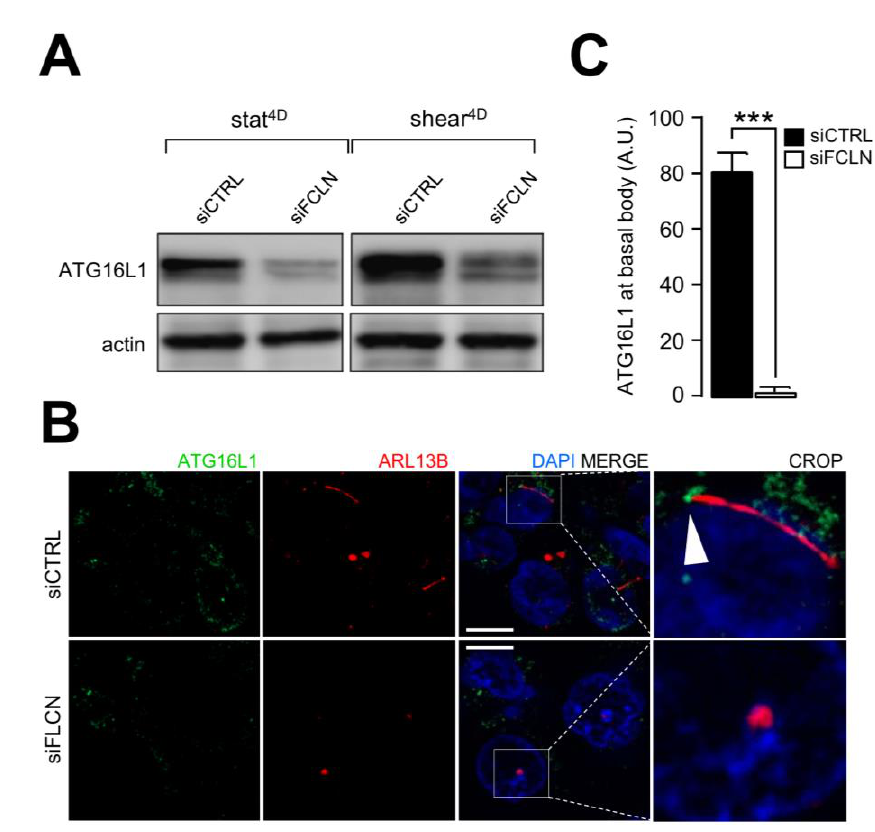
Cell Stress | MARCH 2019 | Vol. 3 No. 3